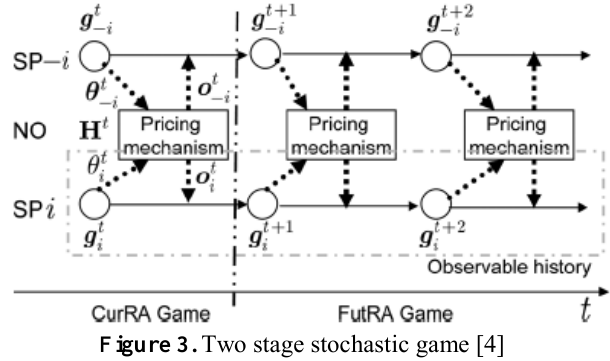
Figure 3. Two stage stochastic game